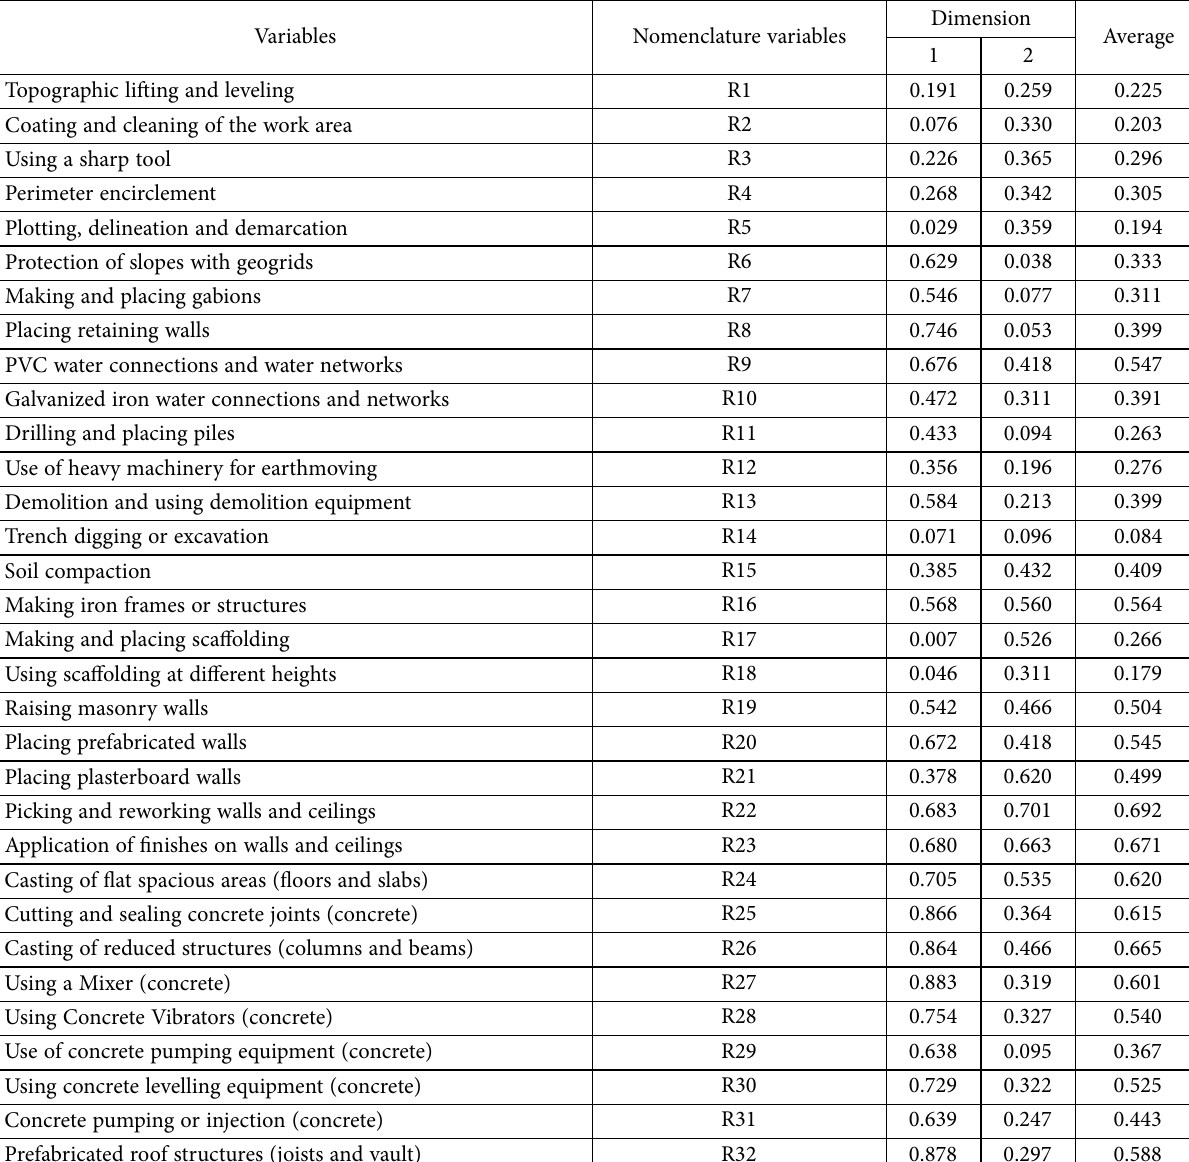
Table 3. Measures of discrimination of the 64 risk-weighting variables for each construction activity and the general company variables for each dimension (Part 1)